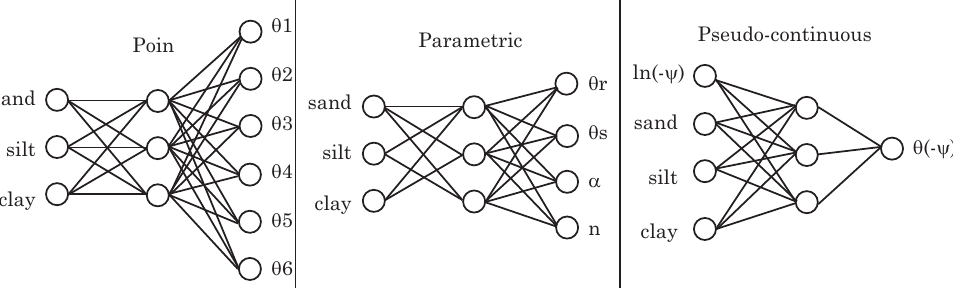
Figure 1. Schematic representation of point-based, parameter-based, and pseudo-continuous pedotransfer functions (PTFs). Source: Haghverdi et al. (2012). Sand, silt, and clay are sand, silt, and clay percentages, which are the common input predictors of PTFs. Bulk density and organic matter content can be added as optional extra predictors. θθθθθ 1 , θθθθθ 2 , ..., θθθθθ 6 are volumetric water contents, which are the outputs of the point-based PTF when using a dataset containing six points of the water retention curve for